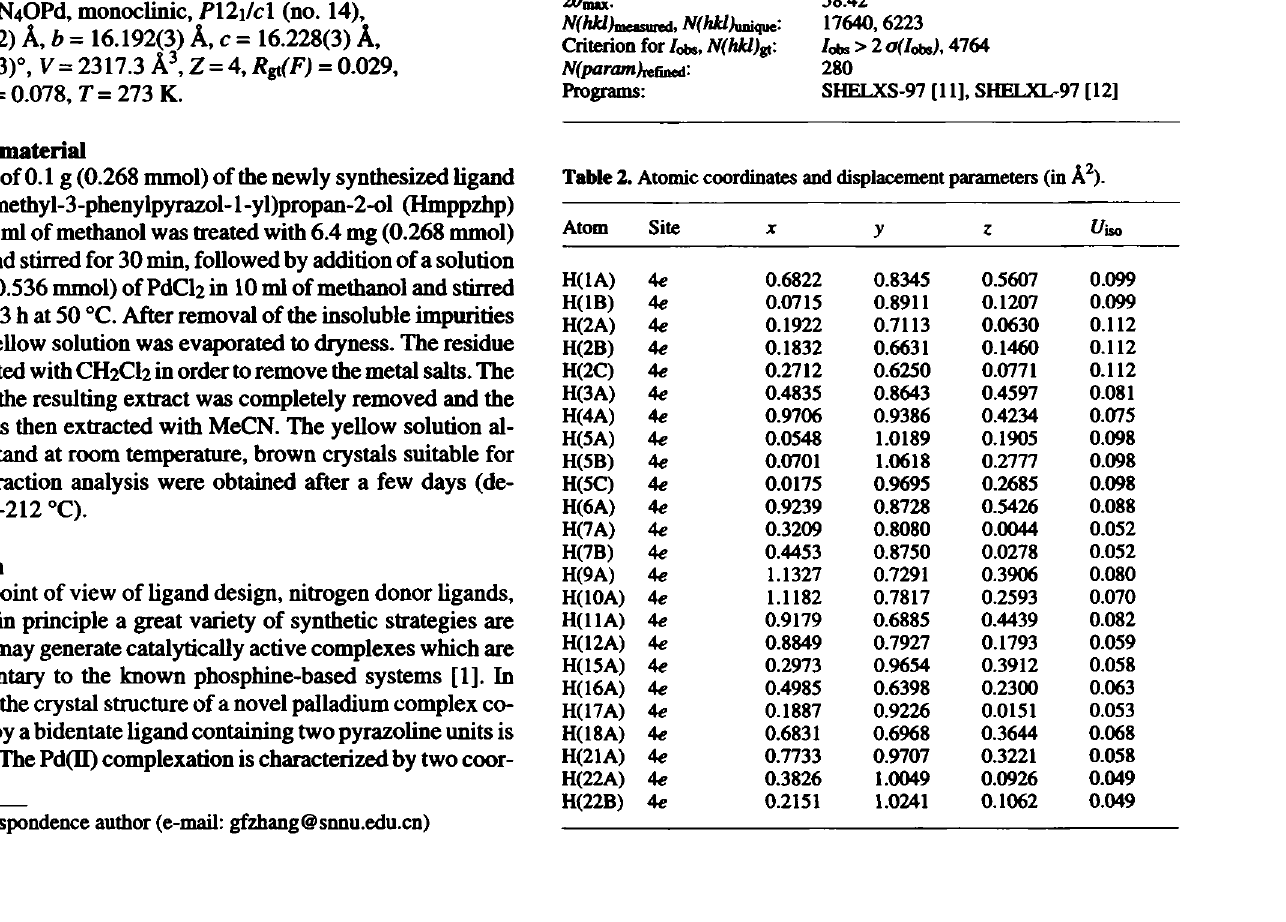
Table 1. Data collection and handling.